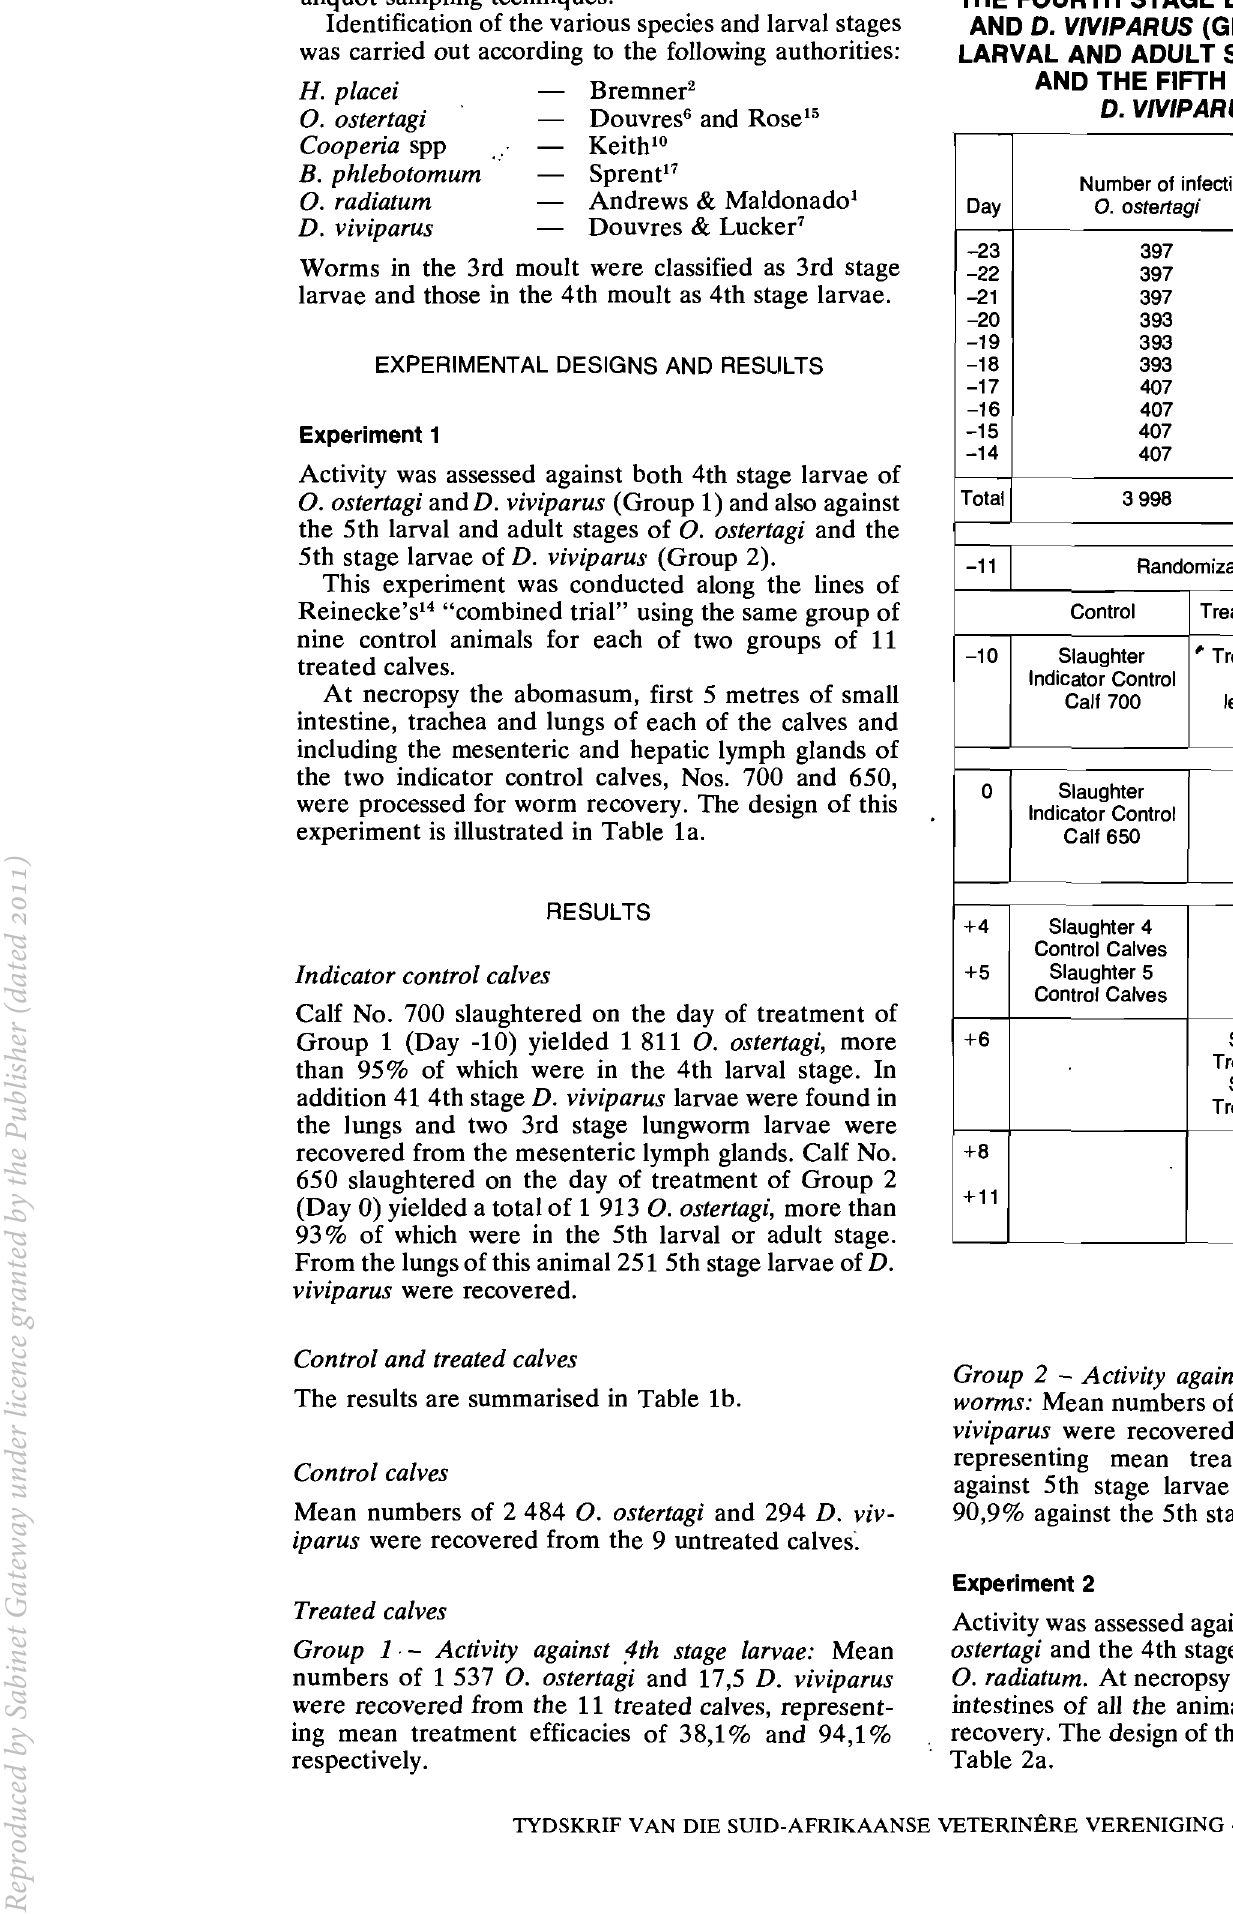
Table 1 a: EXPERIMENT 1. DESIGN OF 'rHE EXPERIMENTS ON ACTIVITY AGAINST BOTH THE FOURTH STAGE LARVAE OF O. OSTERTAGI AND D. VIVIPARUS (GROUP 1), AND THE FIfTH LARVAL AND ADULT STAGES OF O. OSTERTAGI AND THE FIFTH STAGE LARVAE OF D. VIVIPARUS (GROUP